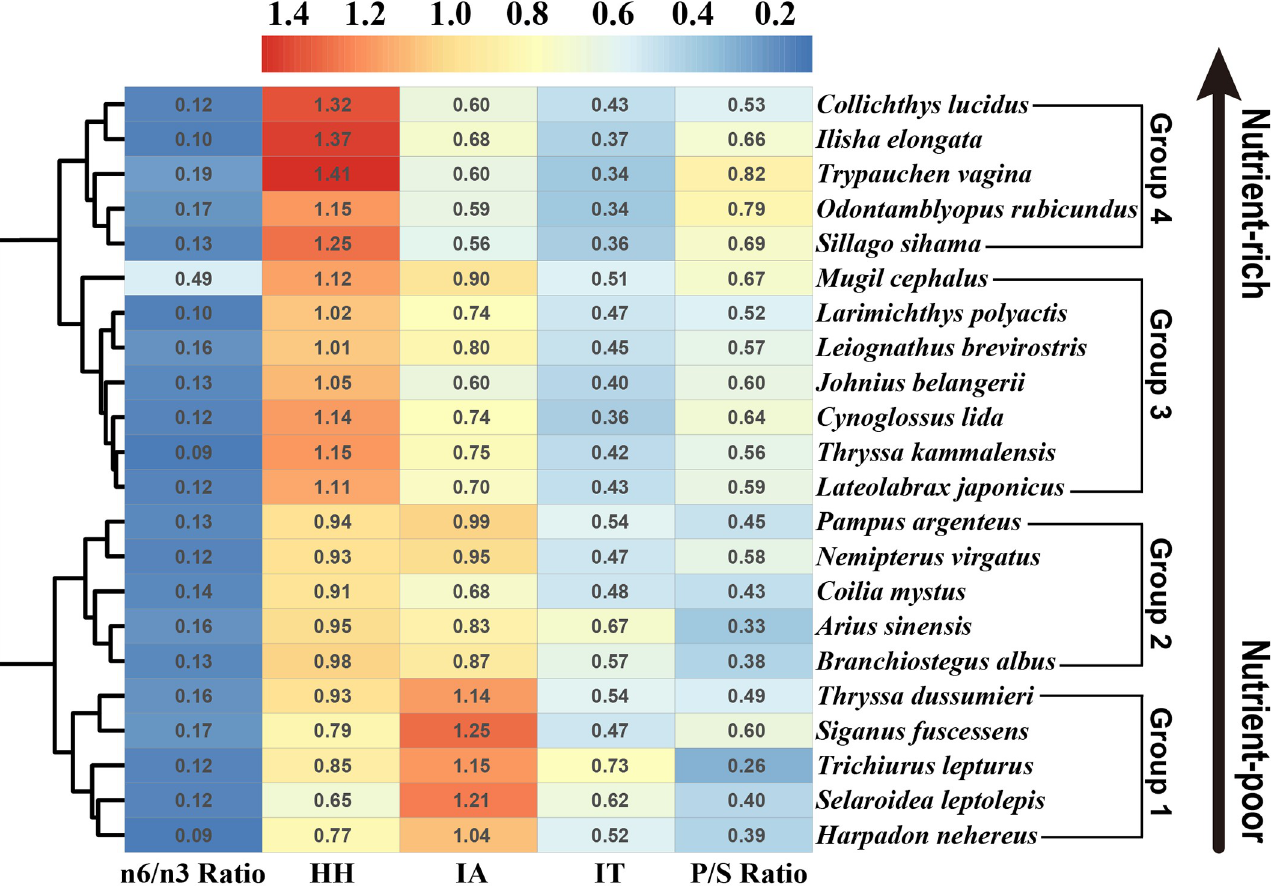
Fig 3. Hierarchical clustering analyses of the selected marine fish species based on the five nutritional quality indices. n-6/n-3 Ratio: n -6 PUFAs/ n -3 PUFAs ratio; HH: hypocholesterolemic/hypercholesterolemic ratio; IA: index of atherogenicity; IT: index of thrombogenicity, P/S Ratio: PUFAs/SFAs ratio.